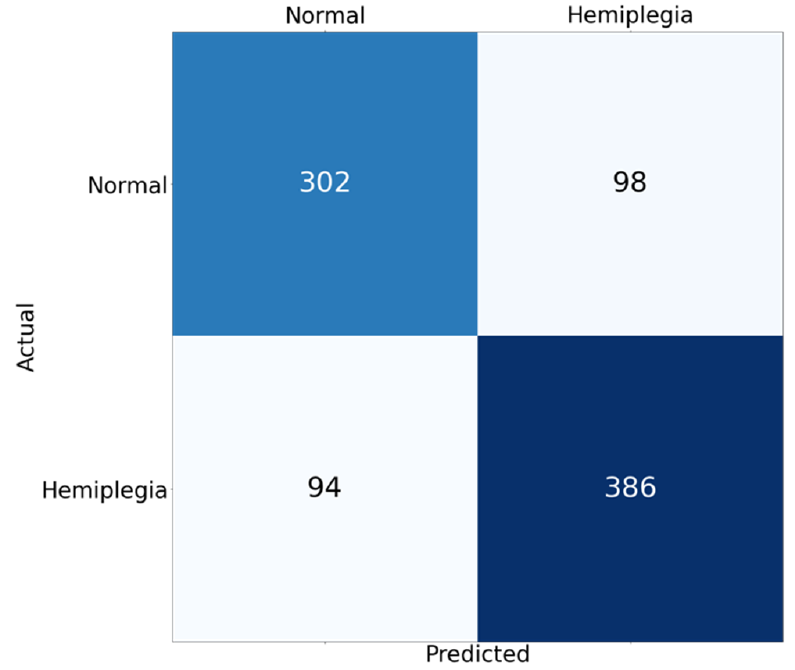
Figure 5. Confusion matrix of the result of proposed classification model. The numbers of true positives, true negatives, false positives, and false negatives are 386, 302, 98, and 94, respectively.